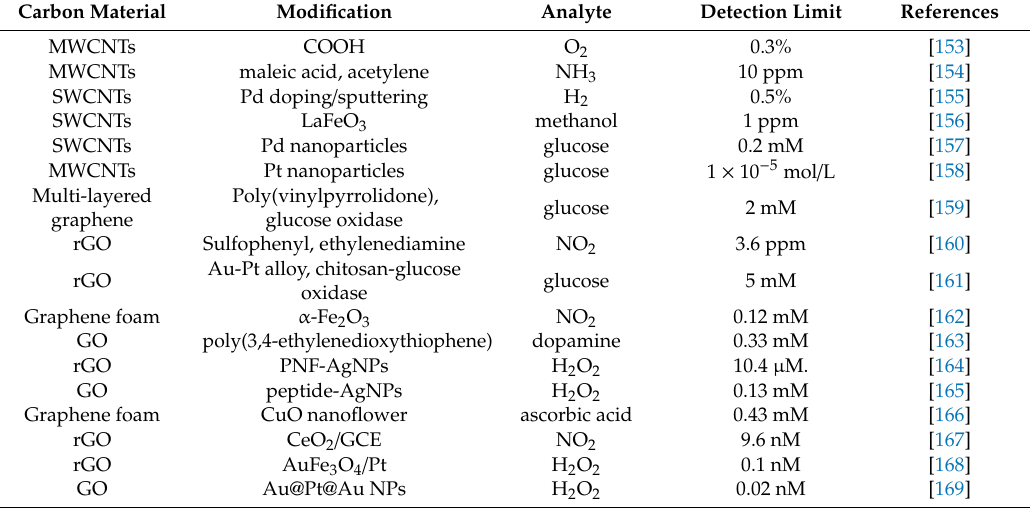
Table 2. Carbon-based hybrids, their functionalization / modification as